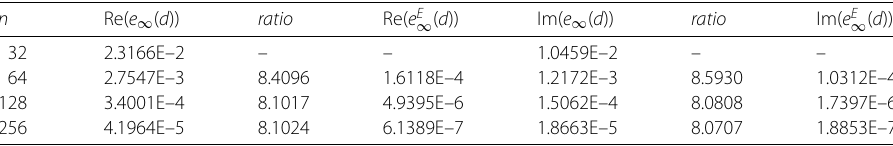
Table 2 Numerical results for the far-field pattern u ∞ ( d ) with k = 5